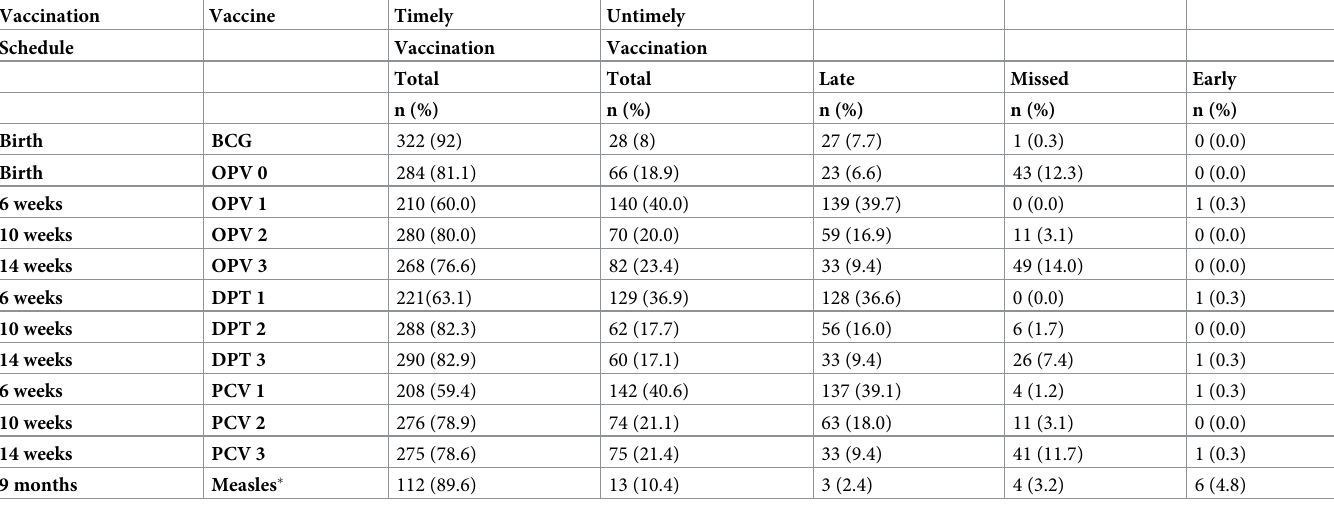
Table 4. Timeliness of each vaccine antigen among 350 preterm infants aged 6–24 months at Mulago Hospital, Kampala, Uganda.